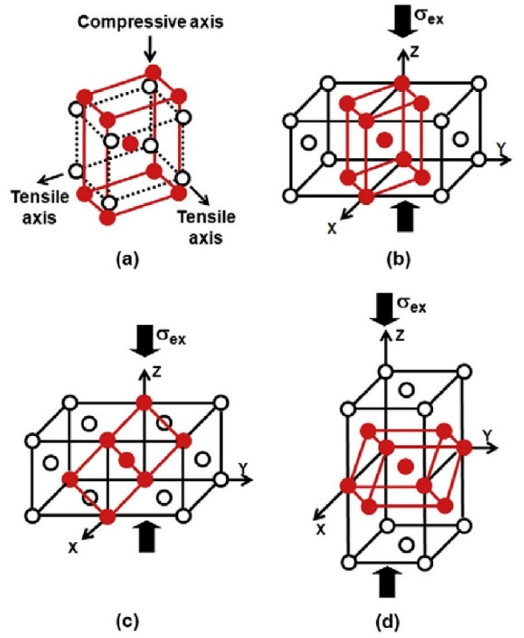
Figure 7. ( a ) Schematic illustration for the arrangement of atoms during the martensitic transfor- mation according to the Bain distortion mechanism. ( b – d ) Three possible Bain variants concerning the loading direction [99]. σ ex : externally applied stress. Black circle and red dot represent the austenite and martensite atoms, respectively. Reprinted with permission from ref. [99]. Copyright